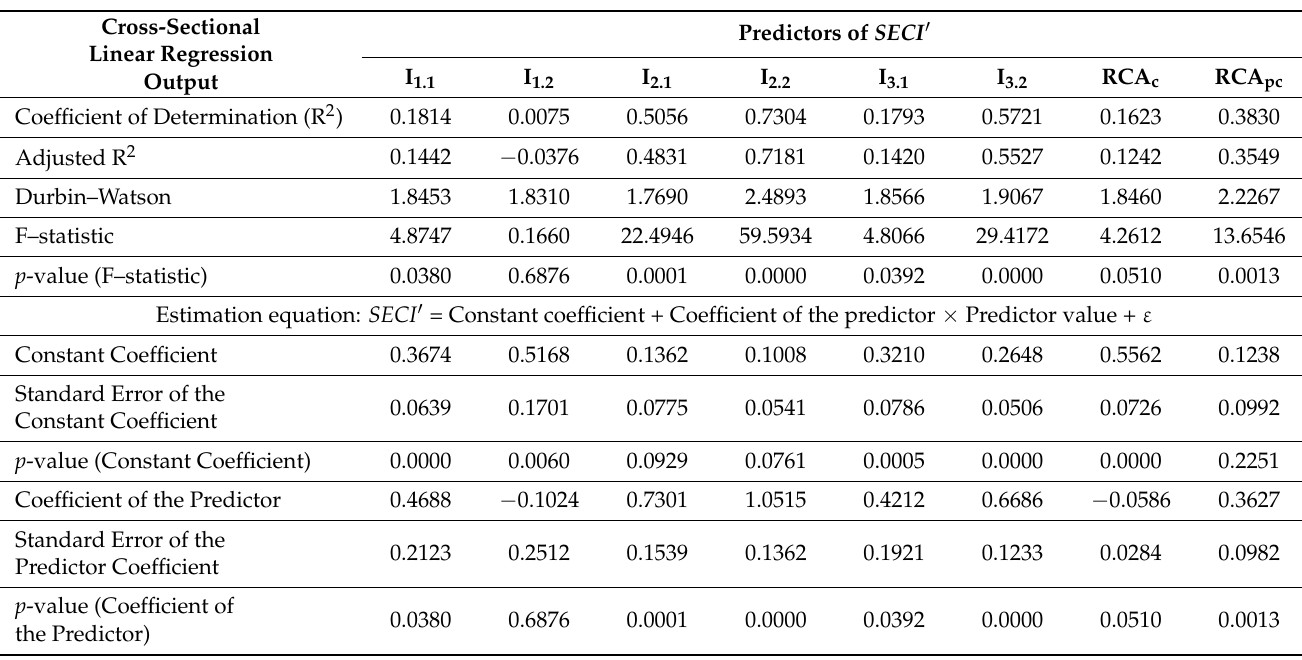
Table 5. The output of the cross-sectional linear regression